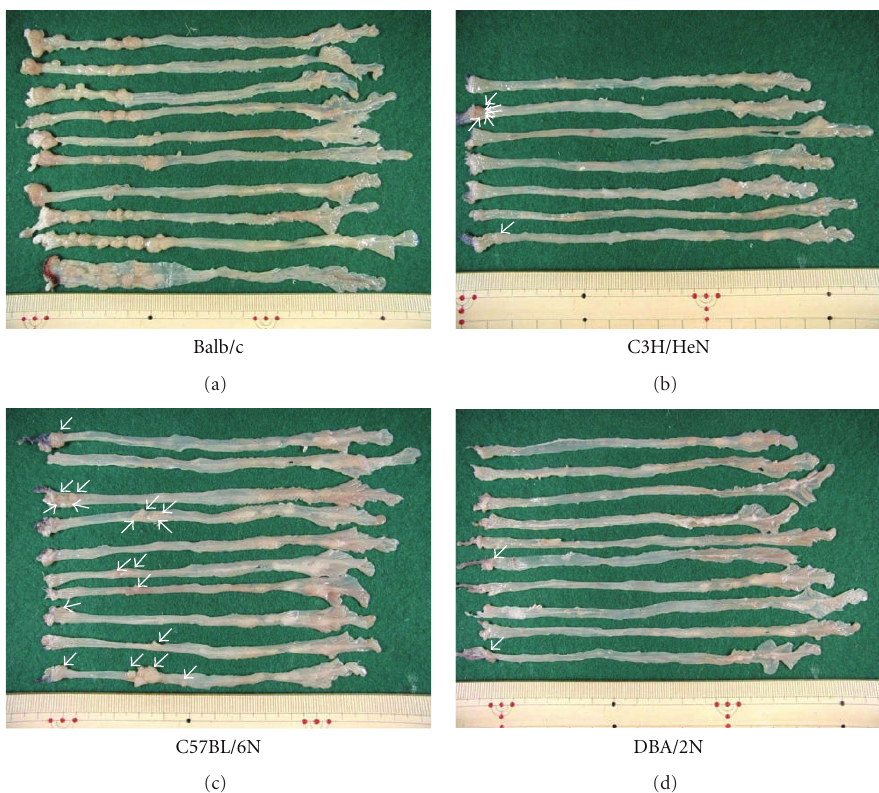
Figure 16: Macroscopic view of large bowel of four strains (Balb/c, C57BL/6N, C3H/HeN, and DBA/2N) of mice that received AOM and DSS.